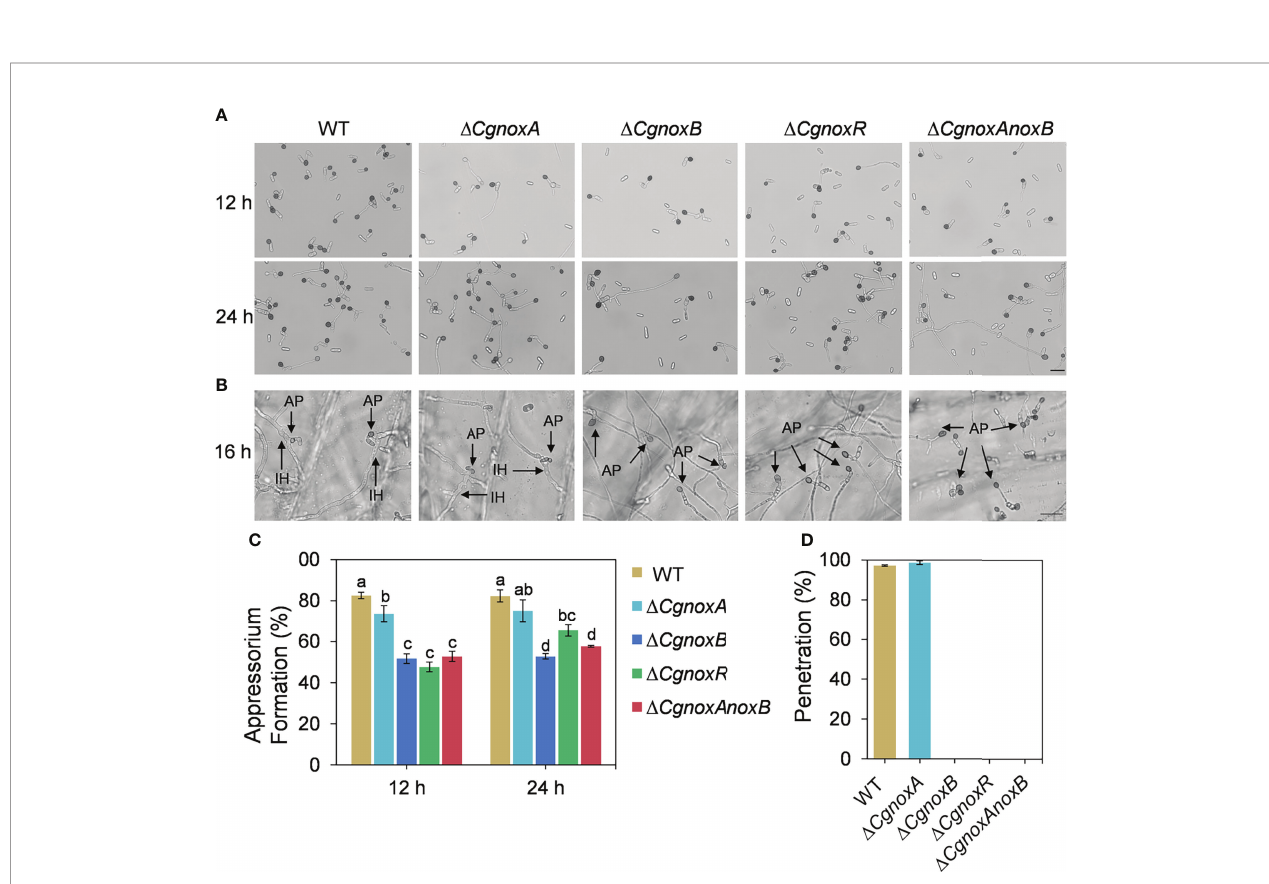
FIGURE 4 | Appressorium formation on hydrophobic plastic plates and onion epidermis. (A) Appressorium formation assay of WT, D CgnoxA , D CgnoxB , D CgnoxR , and D CgnoxAnoxB strains incubation on hydrophobic plastic plates for 12 and 24 h. Scale bar = 20 m m. (B) Appressorium formation and penetration on onion epidermis after 16 h. AP: appressorium, IH: invasive hypha. Scale bar = 20 m m. (C) Appressorium formation rate at 12 and 24 h postinoculation. Bars represent standard deviations (SD). Columns with different letters indicate signi fi cant difference (p < 0.05). (D) Bar charts show the relative percentage penetration of each strain on onion epidermis at 24 hpi, assessed by recording the frequency of hyphal penetration from an appressorium (three biological